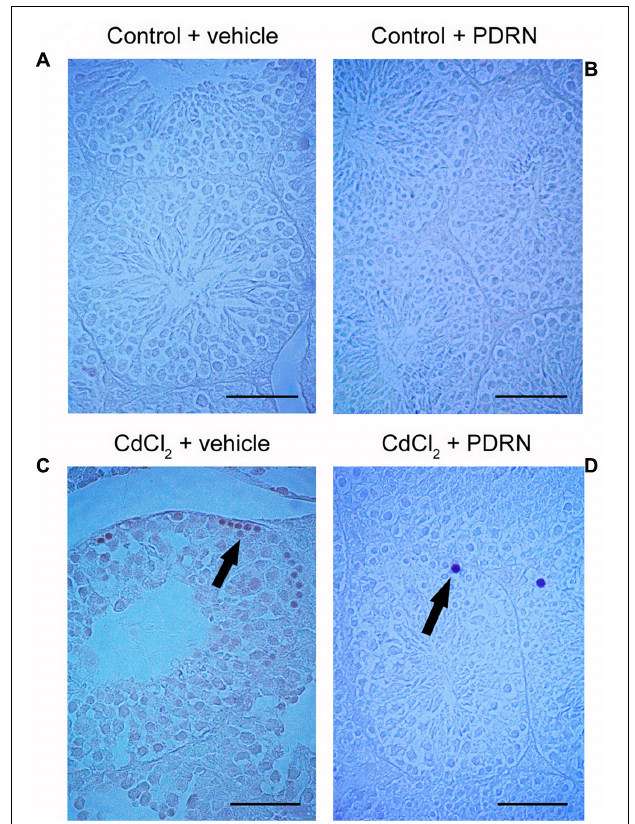
FIGURE 4 | TUNEL staining technique revealing apoptosis in the testes from control plus vehicle animals (A) , control plus PDRN (8 mg/kg i.p.) animals (B) , CdCl 2 (2 mg/kg i.p.) plus vehicle animals (C) , and CdCl 2 (2 mg/kg i.p.) plus PDRN (8 mg/kg i.p.) animals (D) . (A,B) No TUNEL-positive cells are present. (C) Arrow, peripheral clusters of TUNEL-positive cells. (D) Arrow, isolated TUNEL-positive cells. (Scale bar: 50 µ m).